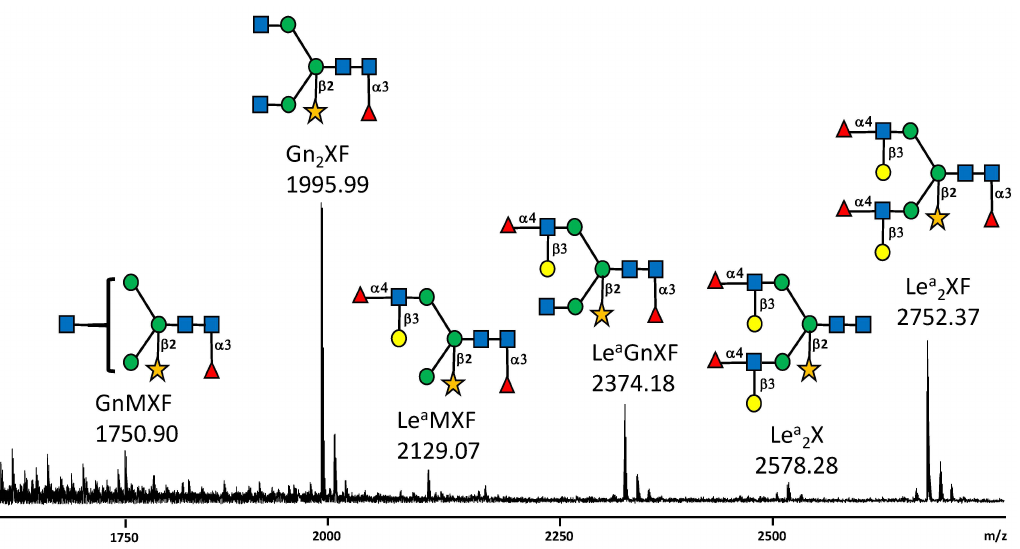
Figure 1. MALDI-TOF mass spectrum profile of [M+Na] + molecular ions of permethylated N -glycans released from the SARS-CoV-2 S protein produced in N. benthamiana . Structures of main oligosaccha- rides are depicted. Each N- glycan has been drawn according to the international nomenclature [22]. Blue square: GlcNAc; green circle: Man; yellow circle: Gal; red triangle: Fuc and yellow star: Xyl. Linkages of monosaccharides to the core GlcNAc 2 Man 3 GlcNAc 2 and linkage of the Le a terminal antennae are indicated. See legend of Figure 2 for nomenclature of plant N -linked